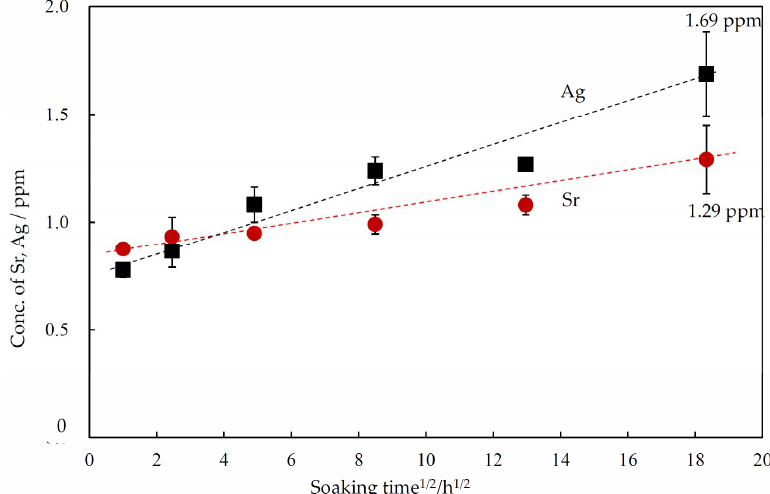
Figure 9. Concentrations of Sr and Ag ions released from Ti subjected NaOH-CaCl 2 -heat-Sr + 1 mM Ag (pH = 4), as a function of square root of soaking time in FBS, which was measured by ICP. Black squares and red circles indicate Ag and Sr, respectively.